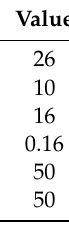
Table 2. Value of parameters of Equation (2).